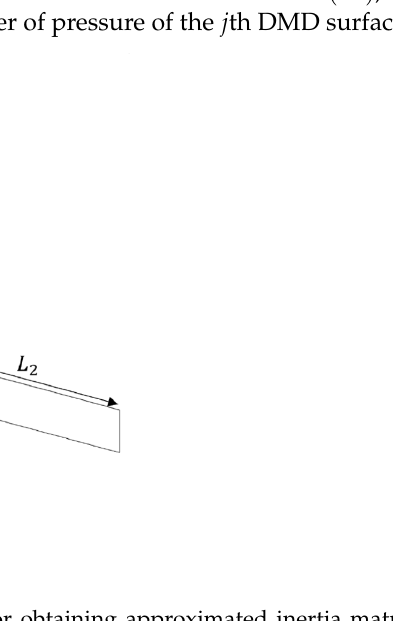
Figure 3. CoM location and model for obtaining approximated inertia matrix as functions the DMD